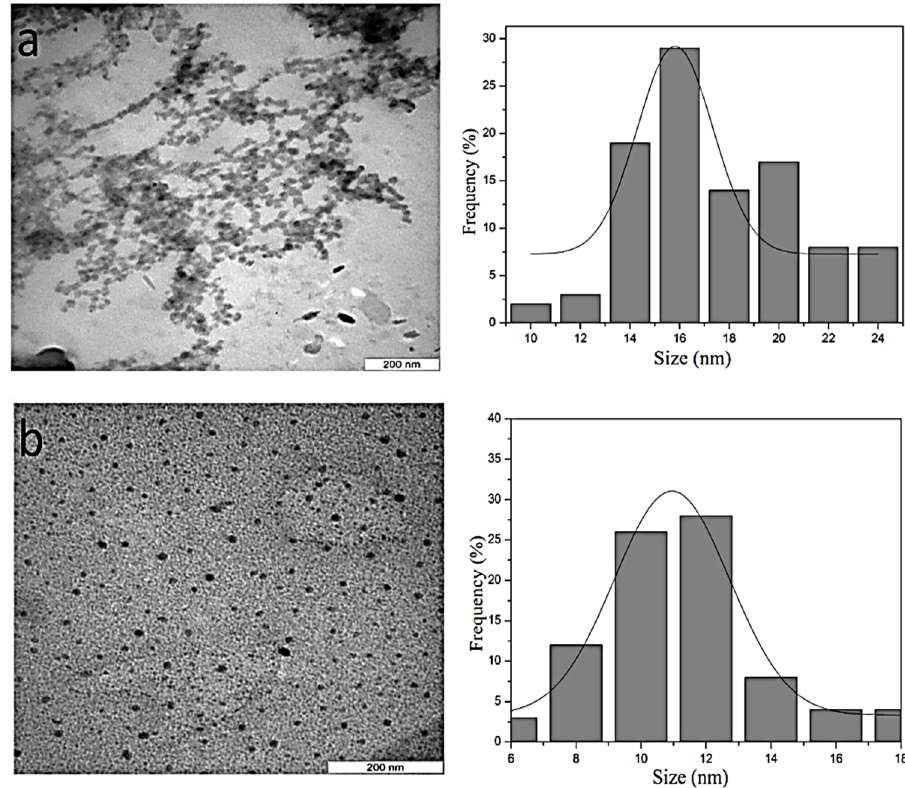
Figure 5. Transmission electron microscopy (TEM) for as prepared ( a ) CdSe and ( b ) ZnSe nanoparticles. Table 2. Crystal structure, size and optical band gap of CdSe and ZnSe nanoparticles.